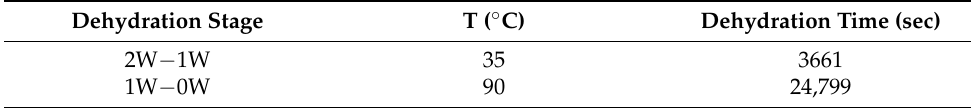
Table 6. Dehydration times for 2W–1W and 1W–0W transitions.